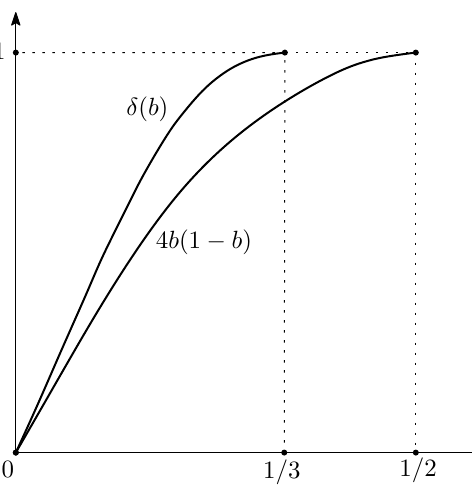
Fig. 3. The comparison of the rate functions δ ( b ) (for the U-algorithm) and 4 b ( 1 the